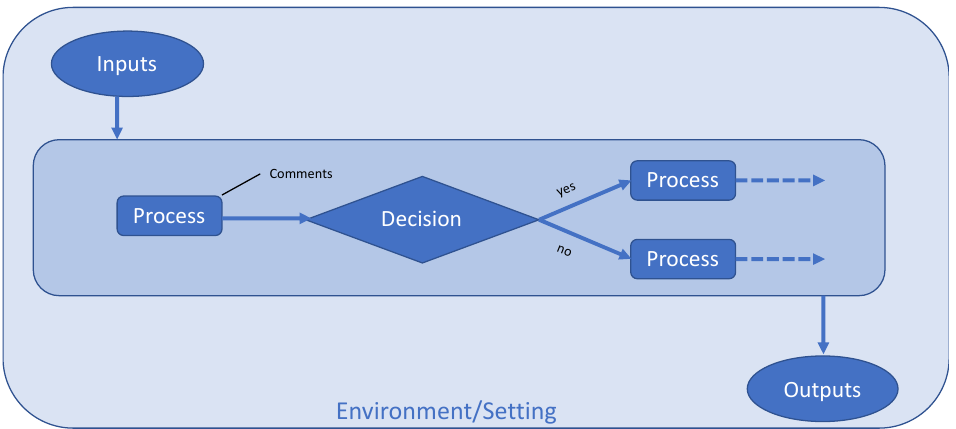
Figure 2. Conventions for symbols in a graphical model of a system.